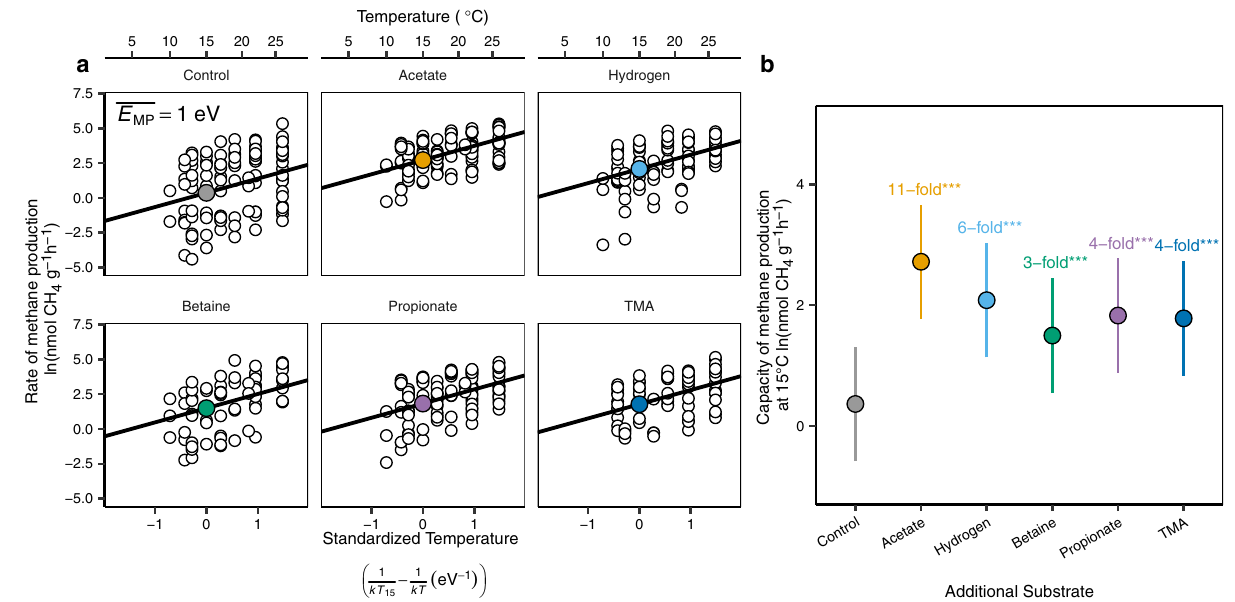
Fig. 3 Temperature sensitivity and capacity of streambed sediments to produce methane with additional substrates ( n = 571 observations in eight streams). a The temperature sensitivity of methane production ( E MP ) was 1.0 eV (95% CI: 0.90 – 1.16) and was conserved both with and without additional substrates. b In contrast, all additional substrates enhanced the capacity of sediments to produce methane relative to unamended controls ( post hoc analysis for pairwise comparison using Tukey method, ***: P < 0.001) — just as for the variation in streambed organic matter content in the fi eld (Fig. 2b). The black solid lines in a represent the slopes, i.e., the temperature sensitivity, and the fi lled colored circles represent the intercepts i.e., the capacity of methane production standardized to 15 °C that are then reproduced for comparison in b . The vertical lines are 95%